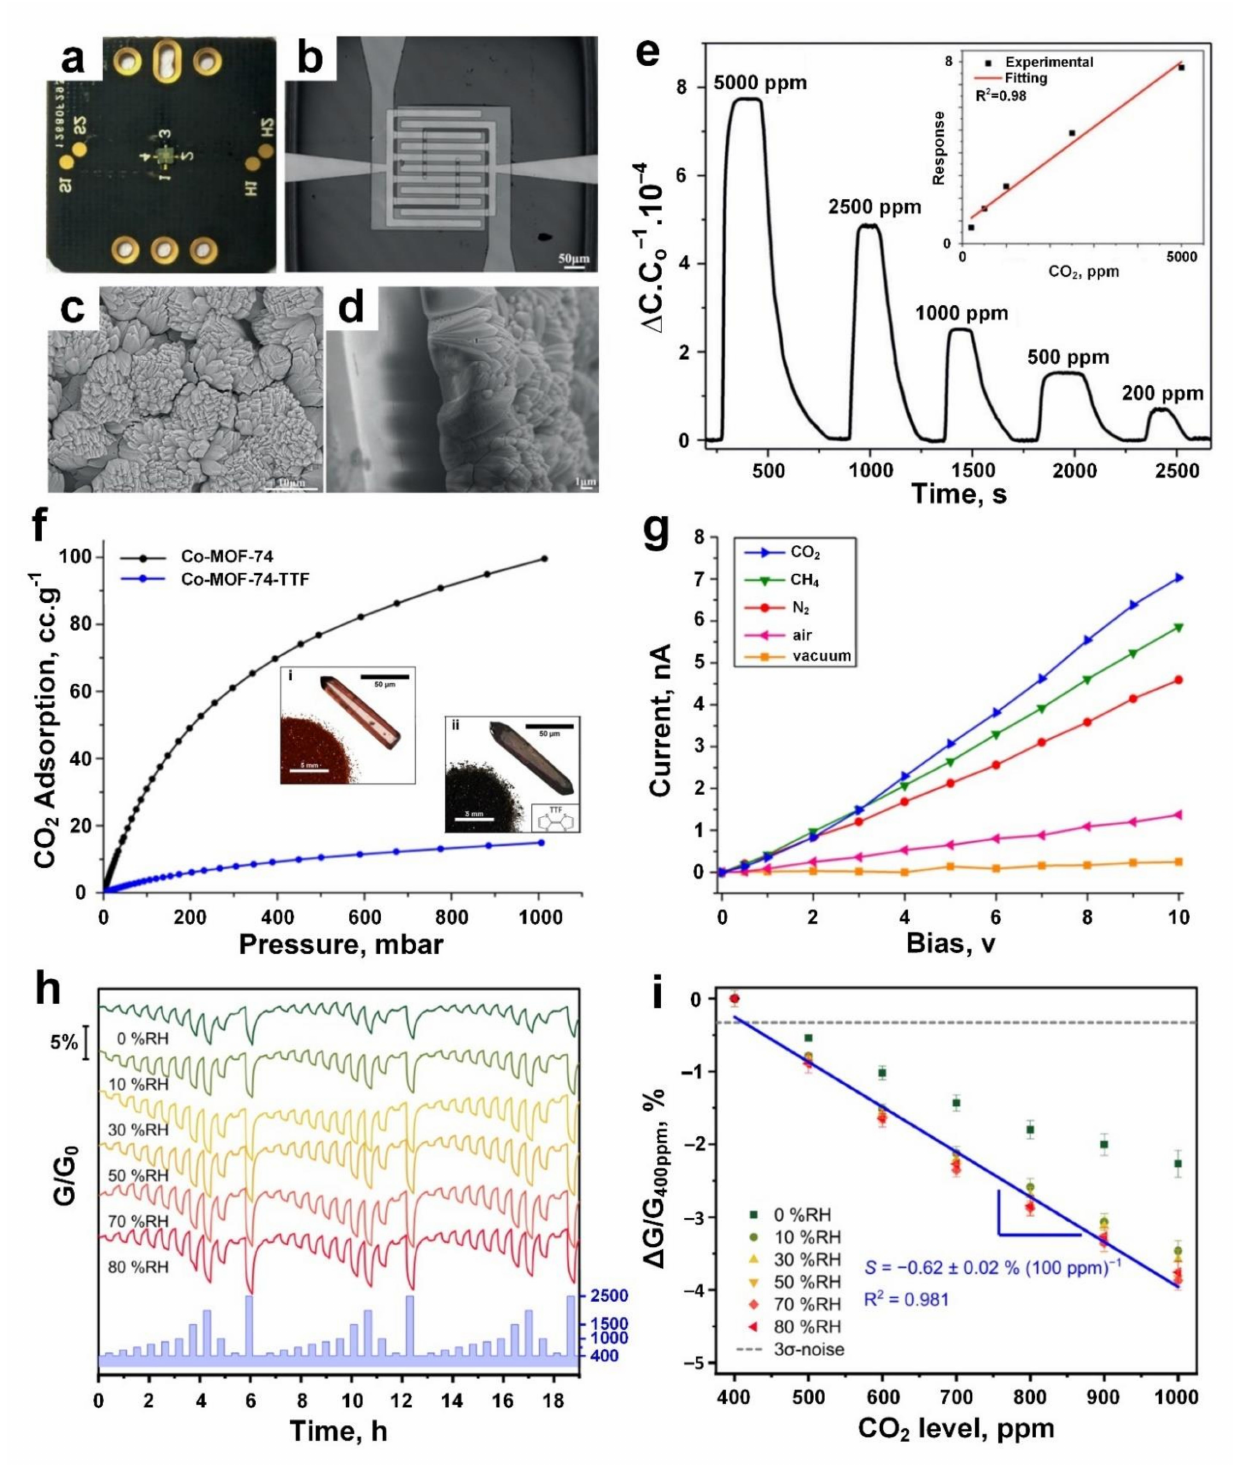
Figure 9. ( a ) Photograph of Mg-MOF-74 film-based CO 2 capacitive gas sensor. ( b ) Optical image of Pt IDEs. ( c , d ) SEM images of the top ( c ) and side ( d ) views of the as-grown Mg-MOF-74 film on IDEs. ( e ) The dynamic response of ethylenediamine-modified Mg-MOF-74 film against CO 2 at different concentrations, the response varied proportionally to the CO 2 concentration (inset). Reproduced with permission from [9] Wiley-VCH, 2019. ( f ) CO 2 adsorption isotherms of Co-MOF-74 (i) and Co-MOF-74-TTF (ii). ( g ) The I-V curves of Co-MOF-74-TTF under CO 2 and other atmospheric conditions. Reproduced with permission from [152] American Chemical Society, 2019. ( h ) The normalized dynamic response curves and, ( i ) response versus CO 2 gas at different concentrations for various humidity scenarios (0 − 80% RH). Reproduced with permission from [104] American Chemical Society,